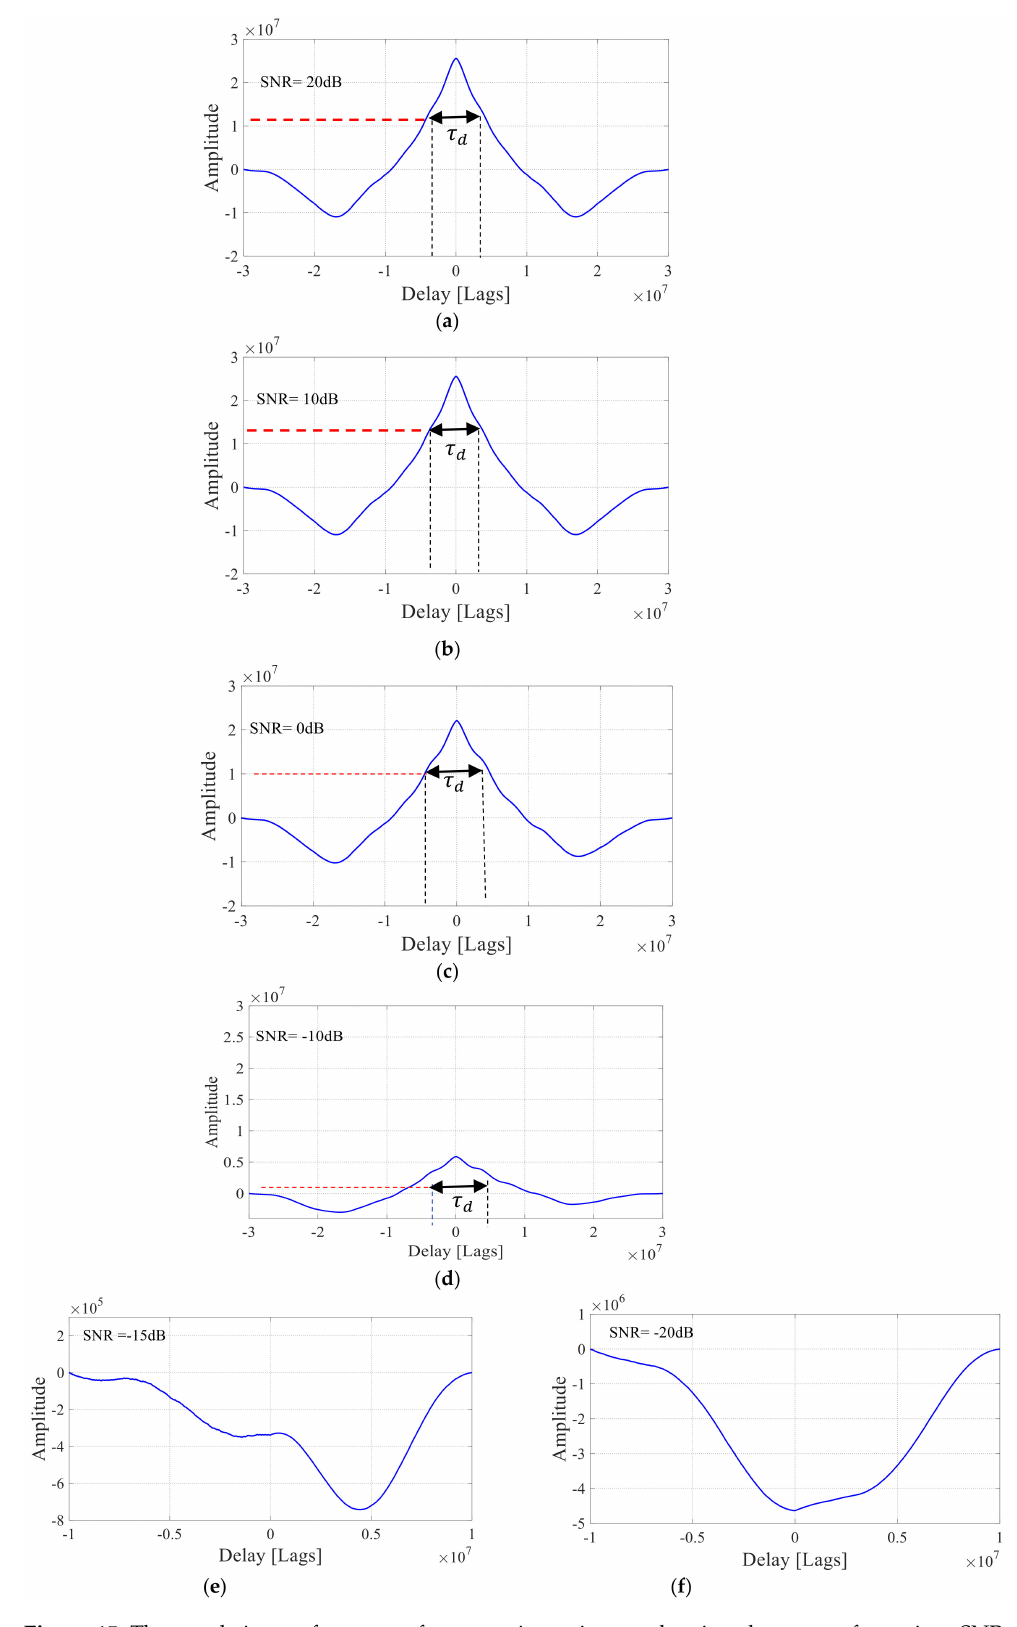
Figure 15. The correlation performance of monostatic continuous chaotic radar system for various